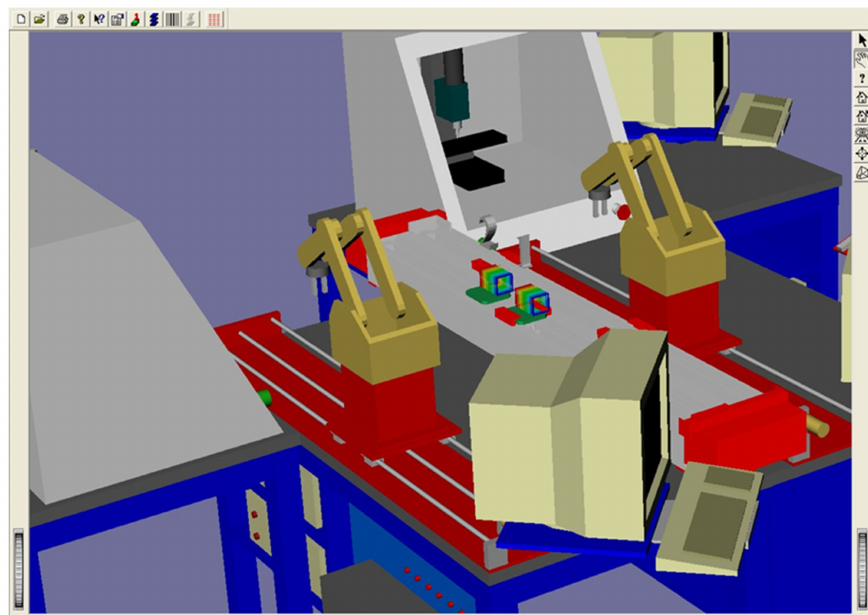
Figure 9. Queue formed at the lathe station.